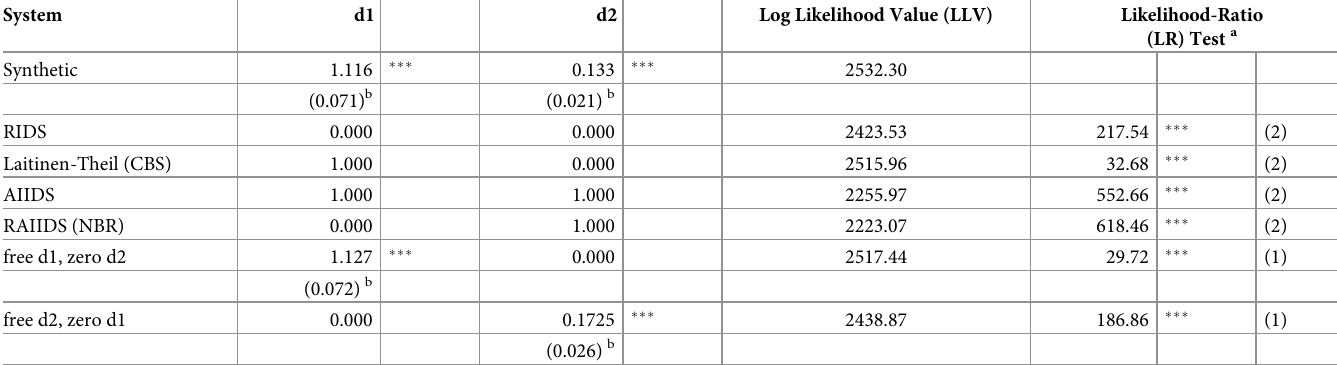
Table 2. Maximum likelihood test statistics of inverse demand systems of the tuna sashimi market in Tokyo, Japan. System